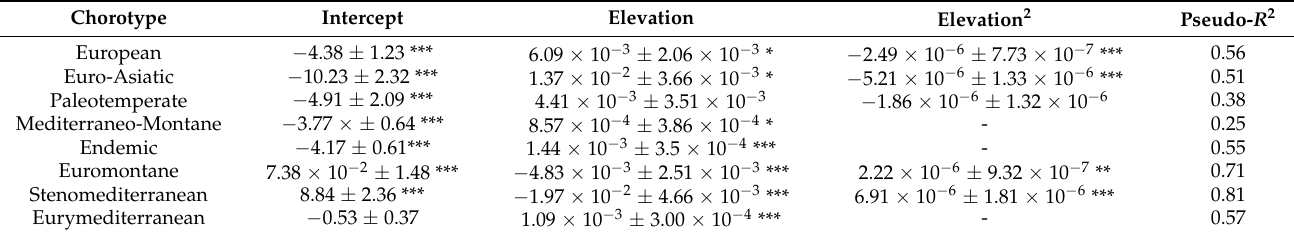
Table 1. Summary statistics of fitted polynomial generalized linear models for proportion of plant chorotypes along an elevational gradient on a Central Apennine mountain (Mount Genzana). Error refers to Standard Errors. Model goodness-of-fit is expressed as McFadden’s psedudo- R 2 . * = p < 0.05; ** = p < 0.01; *** p < 0.001. Chorotype